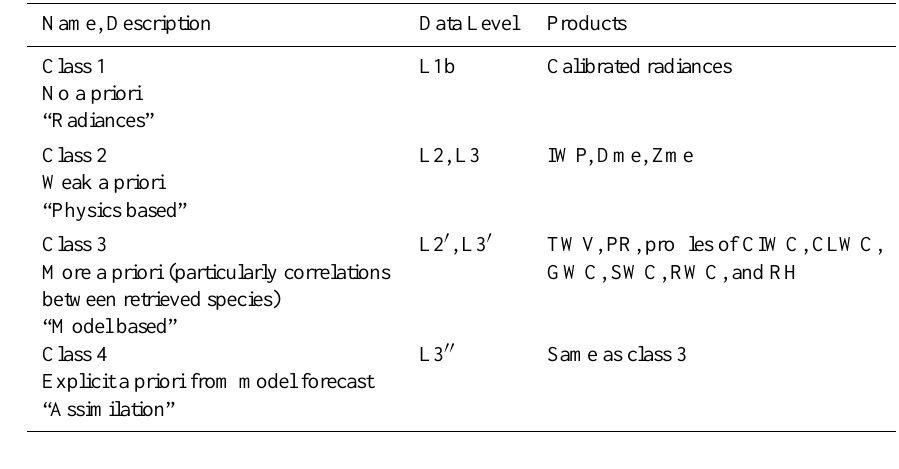
Table 6. Retrieval product classes. Classes 1 and 2 are the primary ones, for which the mission is sized. Classes 3 and 4 would be provided on a best-effort basis.